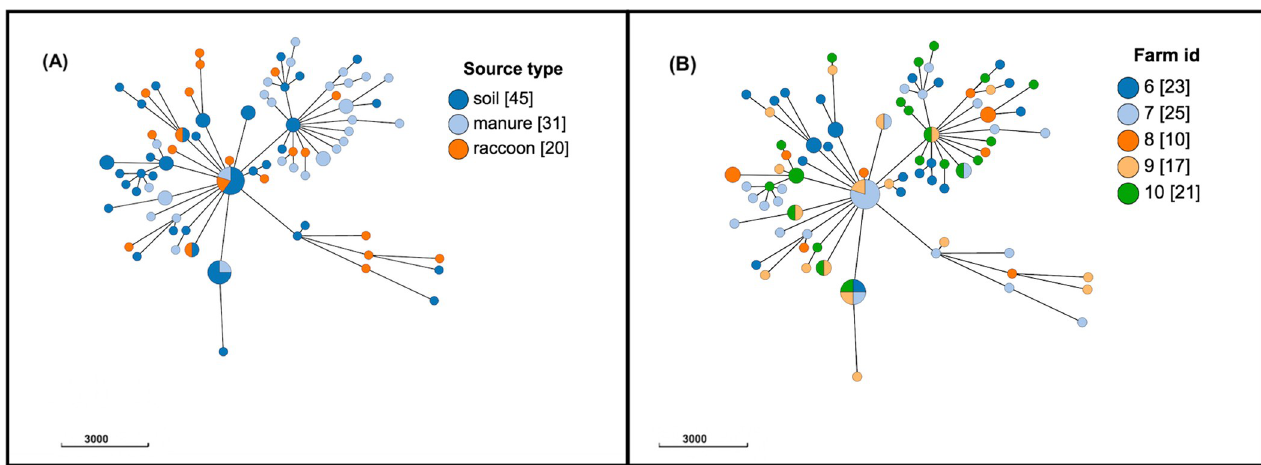
Fig 3. Population structure of 96 phenotypically resistant Escherichia coli isolates from raccoons, swine manure pits, and soil on swine farms in southern Ontario, Canada based on 2513-loci cgMLST scheme from Enterobase. Minimum spanning tree created using k = 50 clustering threshold in GrapeTree . (A) Distribution by source type. (B) Distribution by farm location. Frequency counts are in square brackets. Bubble size is proportional to the number of isolates in each cluster, and each cluster contains isolates differing at a maximum of 50 cgMLST loci.